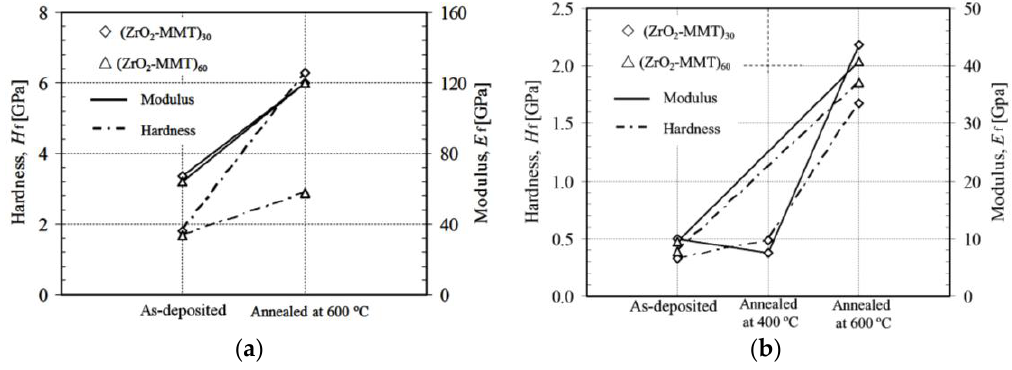
Figure 7. Hardness and modulus of zirconia-clay multilayers under as-deposited and annealed at 400 °C/600 °C conditions with clay montmorillonite 0.03 wt % ( a ) and 0.4 wt % ( b ).